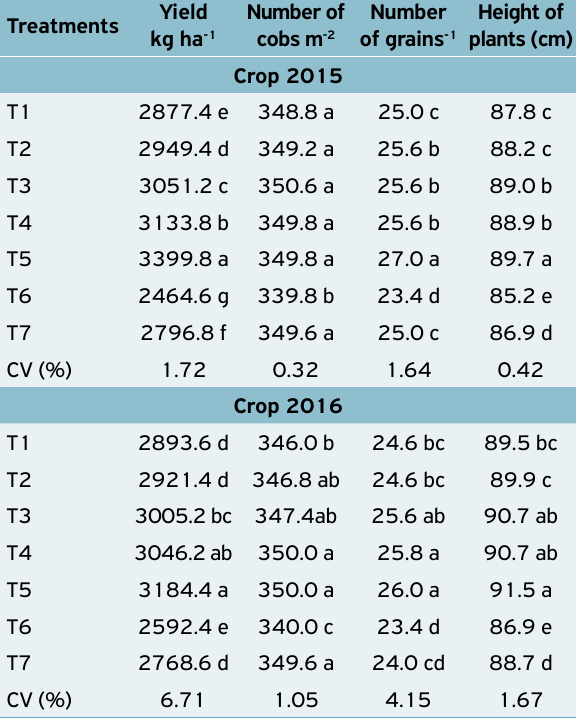
Table 1. Plant height and productivity of wheat cultivar BRS Sabiá, Campus Cedeteg, Universidade Estadual do Centro- Oeste, Guarapuava, PR, Brazil.